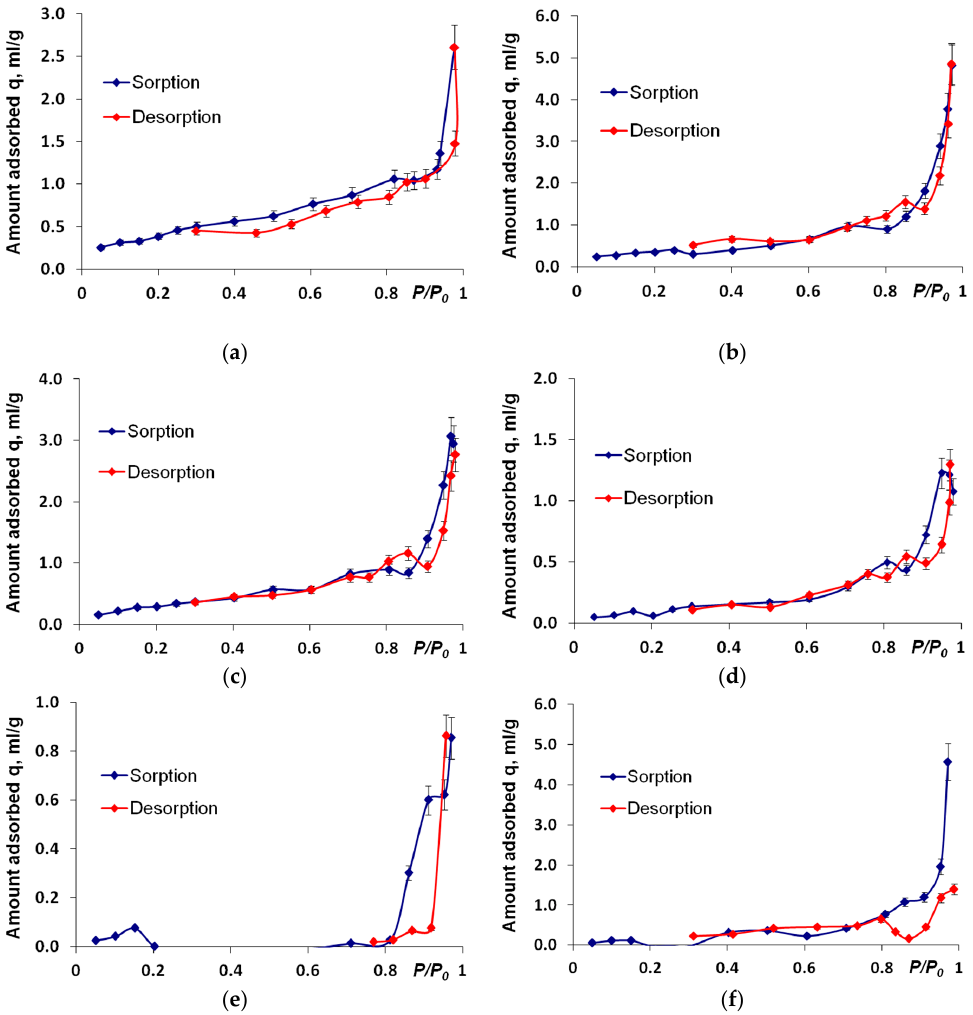
Figure 2. The isotherms of nitrogen adsorption onto biomass carbohydrates: ( a ) α -cellulose, ( b ) sigmacell cellulose, ( c ) β -glucan, ( d ) konjac gum, ( e ) potato starch, and ( f ) corn starch. The results obtained for the main biomass carbohydrates (cellulose and β -glucan) using the single-point and multipoint BET methods demonstrate that this technique is characterized by high